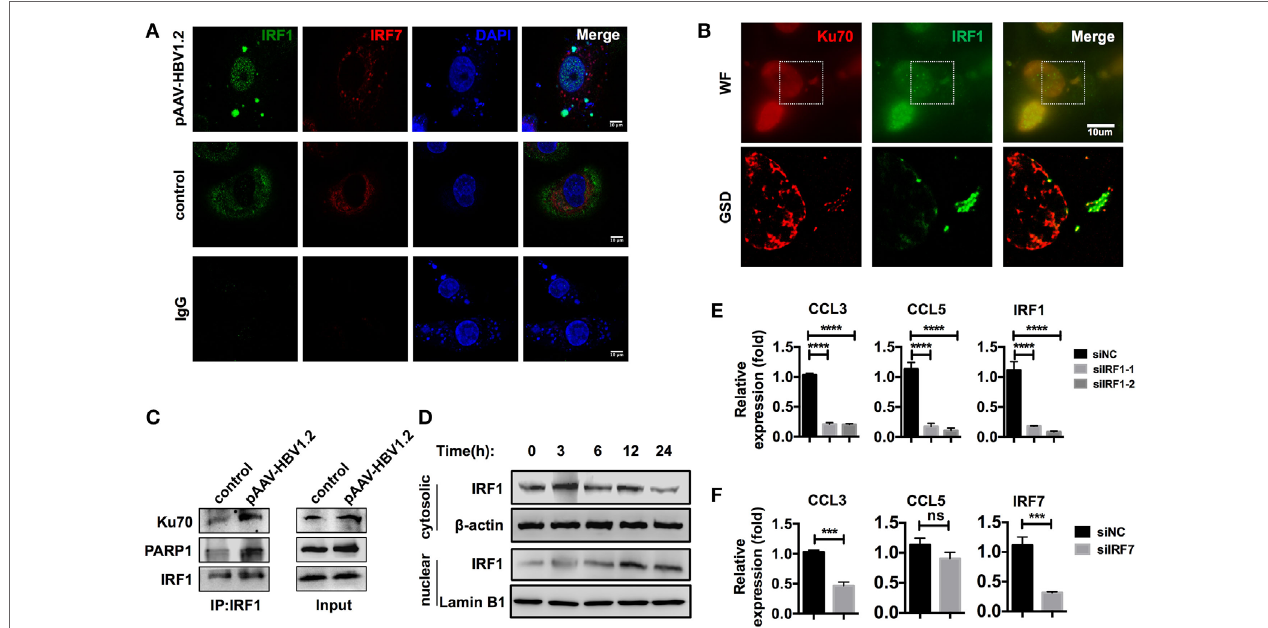
FigUre 7 | irF1 acts as the key transcription factor in this chemokine upregulation pathway . (a,B) SK-Hep-1 cells were transfected with pAAV-HBV1.2 plasmid (medium as control). Six hours later, the cells were fixed and labeled using immunofluorescence. Subsequently, the cells were imaged using confocal (a) or GSD systems (B) Scale bars: 10 μ m. (c) SK-Hep-1 cells were transfected with pAAV-HBV1.2 plasmid (medium as control). Six hours later, IRF1 was immunoprecipitated from the cell lysate. Western blotting was performed to analyze the Co-IP samples. (D) SK-Hep-1 cells were harvested at 3–24 h after pAAV-HBV1.2 plasmid transfection. IRF1 expression in the cytosol and nuclear was determined by Western blotting. (e,F) IRF1 (e) or IRF7 (F) expression was knocked down by RNAi in SK-Hep-1 cells 24 h before the transfection of pAAV-HBV1.2 plasmid. RT-PCR and real-time qPCR were subsequently used to determine the mRNA expression changes ( n =